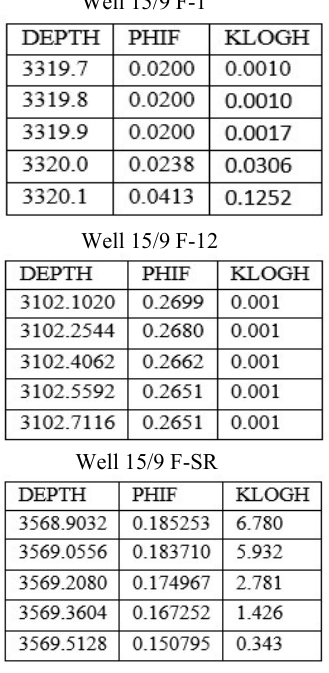
Table 2. Represents values of test wells shown in figure 2. first five points representing porosity and permeability out of 12,301 total points in all three wells (modified)